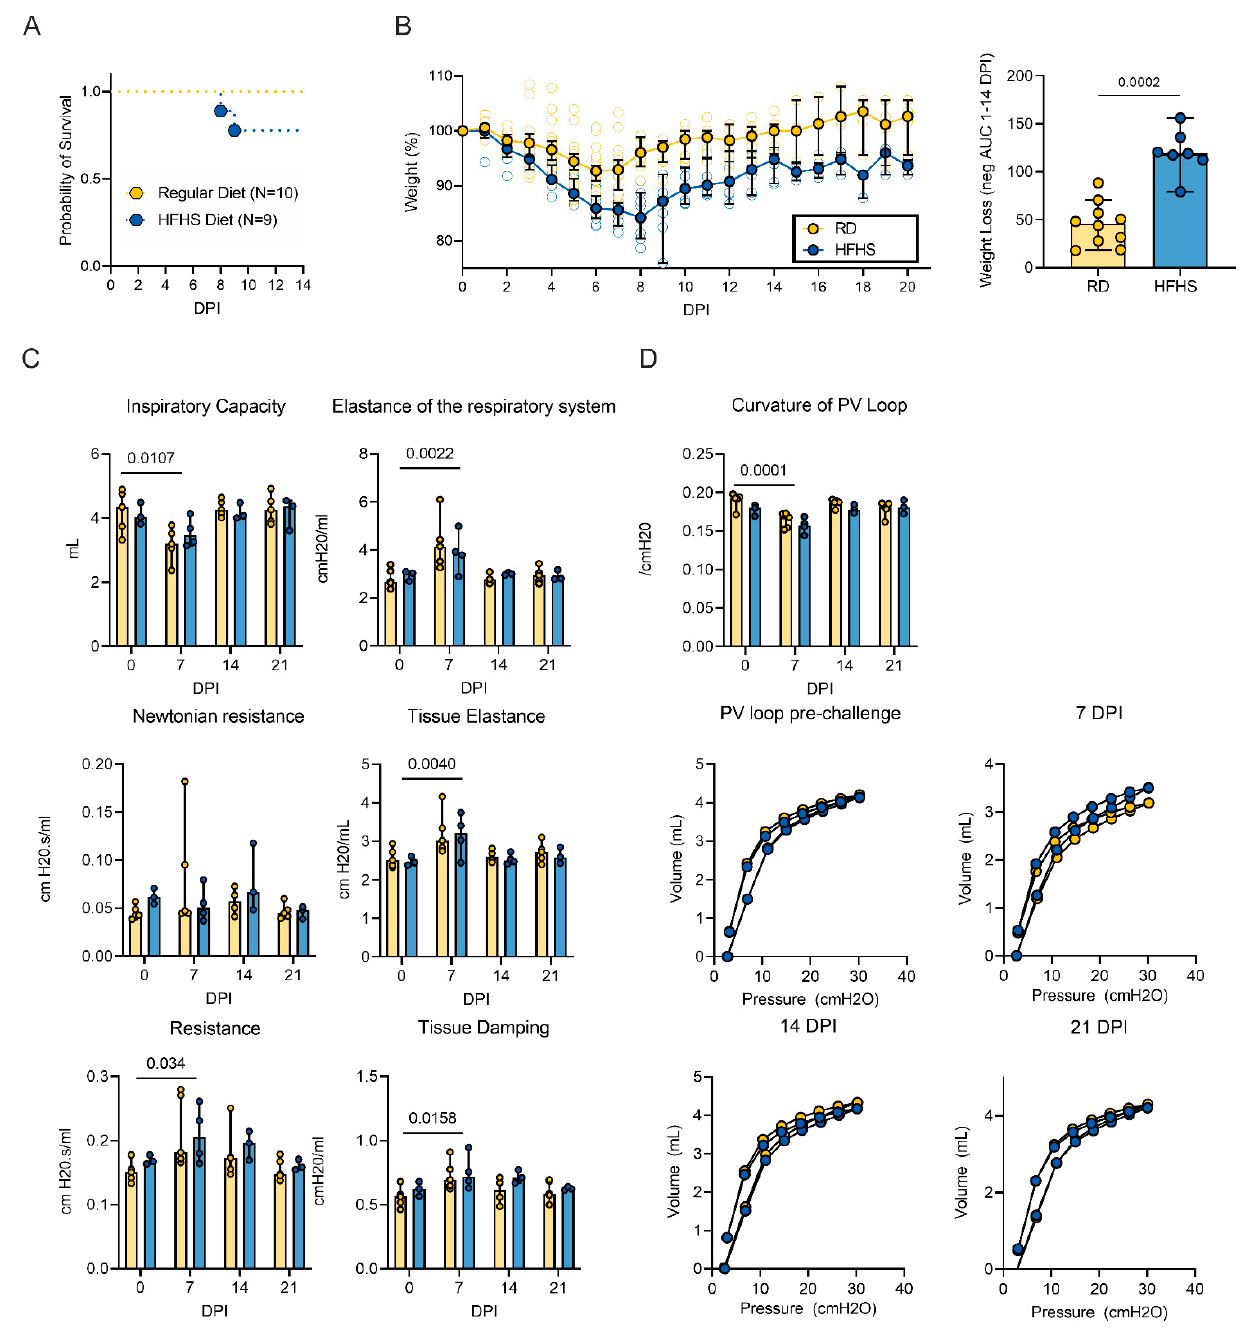
Figure 3. High-fat and high-sugar diet exasperated disease severity after SARS-COV-2 infection. Male Syrian hamsters were fed either a regular or high-fat high-sugar diet ad libitum for 16 weeks, then challenged with 8 × 10 4 TCID50 SARS-CoV-2. ( A ) Survival after challenge for RD ( n = 10) and HFHS ( n = 9) in the 14 and 21 DPI groups. ( B ) Relative weight loss in hamsters after challenge. Left graph shows median ± 95% CI. Right graph shows area under the curve (AUC, negative peaks only) between 1 and 14 DPI of surviving animals. Bar chart depicting median, 95% 0 CI and individuals, n = 10 (RD)/7 (HFHS), Mann–Whitney test. ( C ) Lung function analysis after challenge. ( D ) Pressure–volume loops at pre-challenge, 7, 14, and 21 DPI. Abbreviations: RD = regular diet; HFHS = high-fat high-sugar; DPI = days post inoculation. p -values are indicated were appropriate.